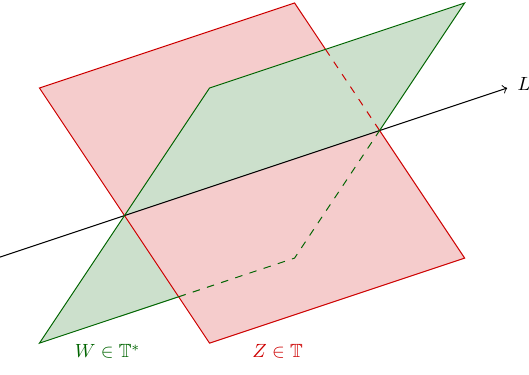
Figure 1 . Twistor description of ambitwistor space in